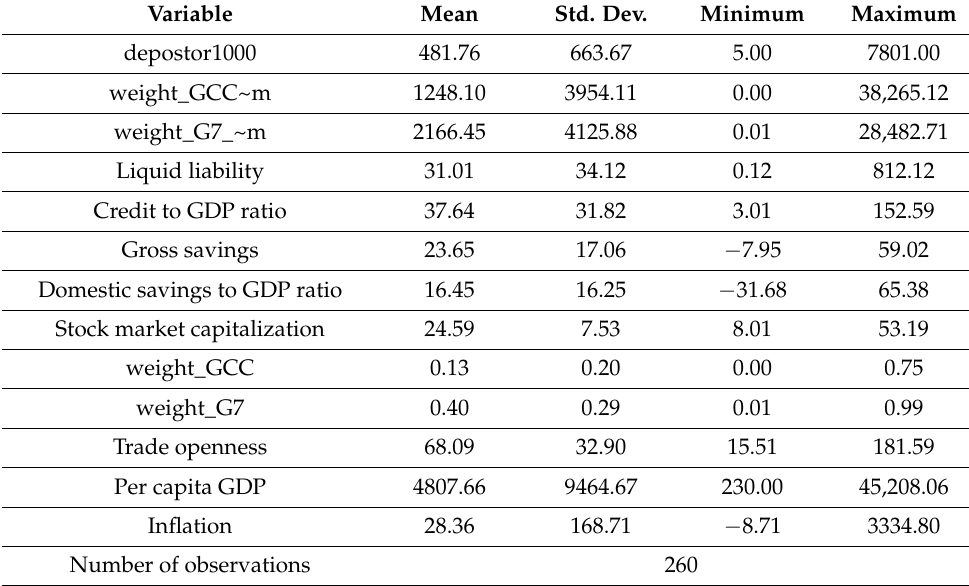
Table 1. Summary